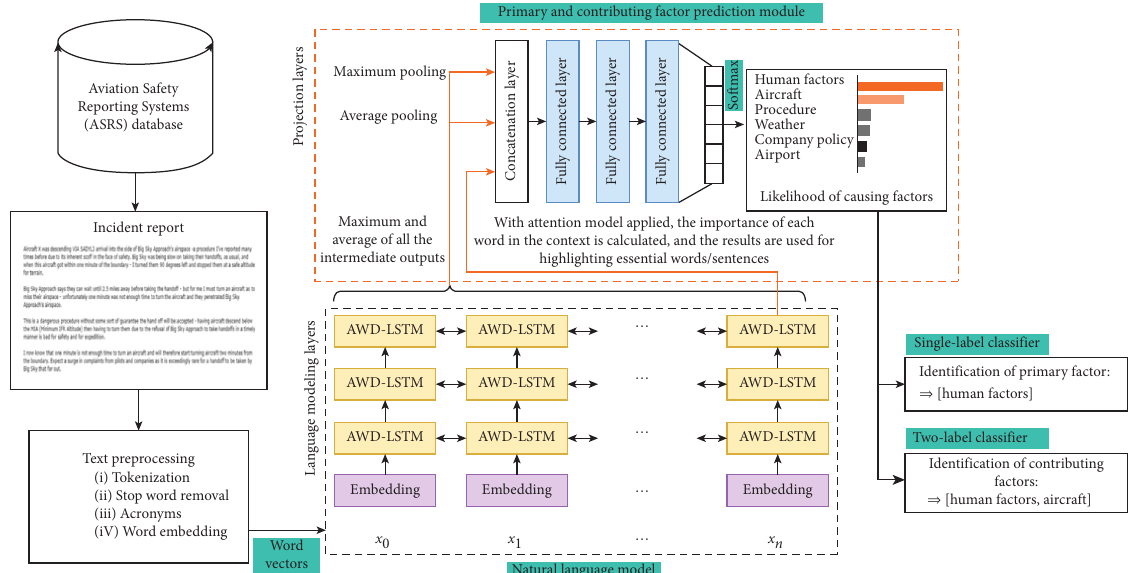
Figure 3: End-to-end diagram of the identification of factors of incident reports. Incident reports including the narratives are downloaded from the ASRS database. After being preprocessed, they are fed to deep neural network model which is composed of two components: (i) a language modeling module, an input layer of embedding and three stacked layers of bidirectional AWD-LSTM recurrent neural networks; and (ii) a prediction module, a flatten layer and three fully connected layers. After processing by these two modules, a probability score is assigned to each factor. Finally, the primary and contributing factors are predicted based on the ranking of probability scores.